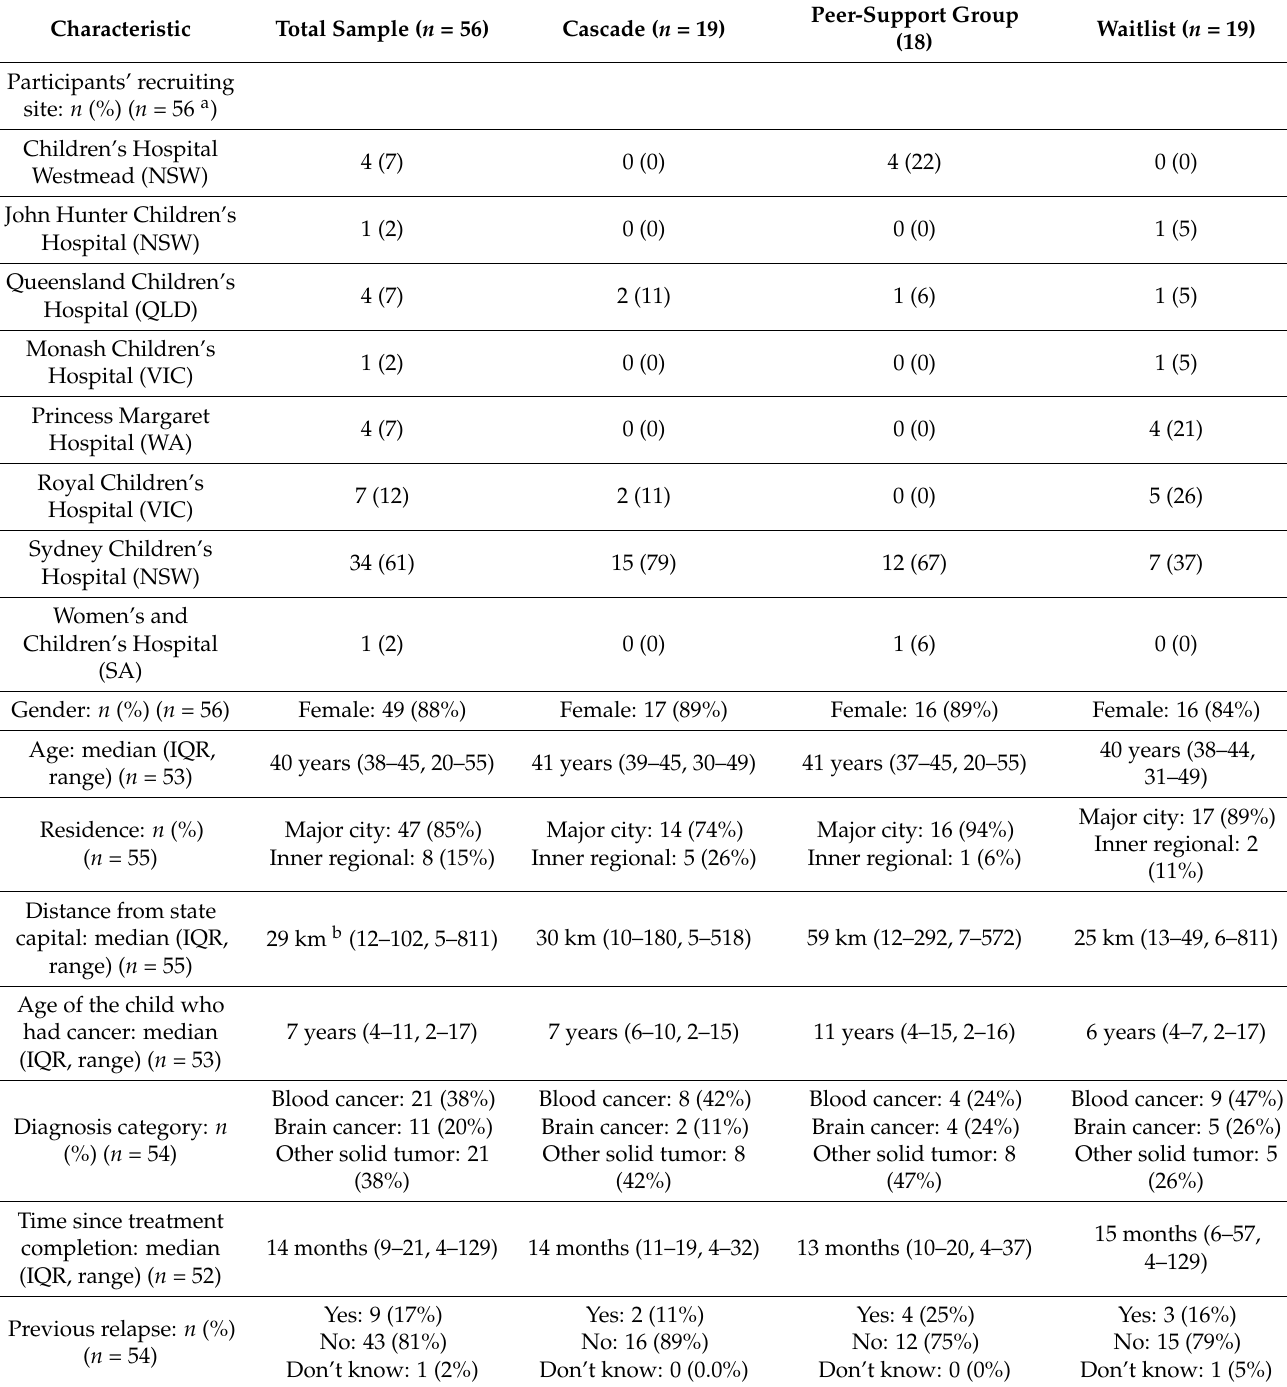
Table 3. Baseline (Q1) sociodemographic characteristics of parents and clinical characteristics of their child who survived